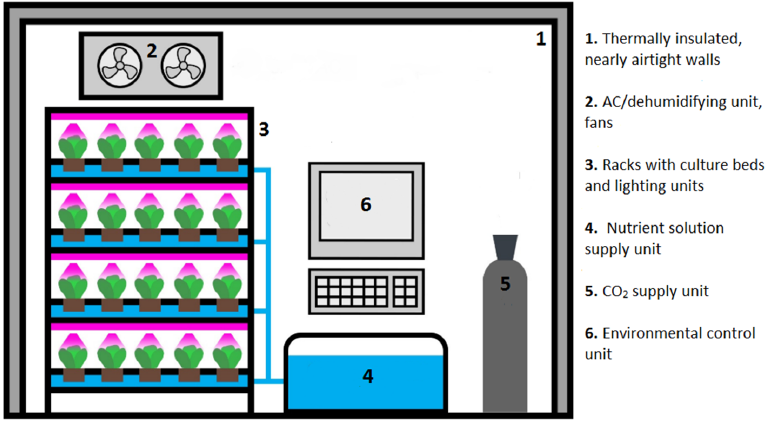
Figure 2. Main elements of a typical VF